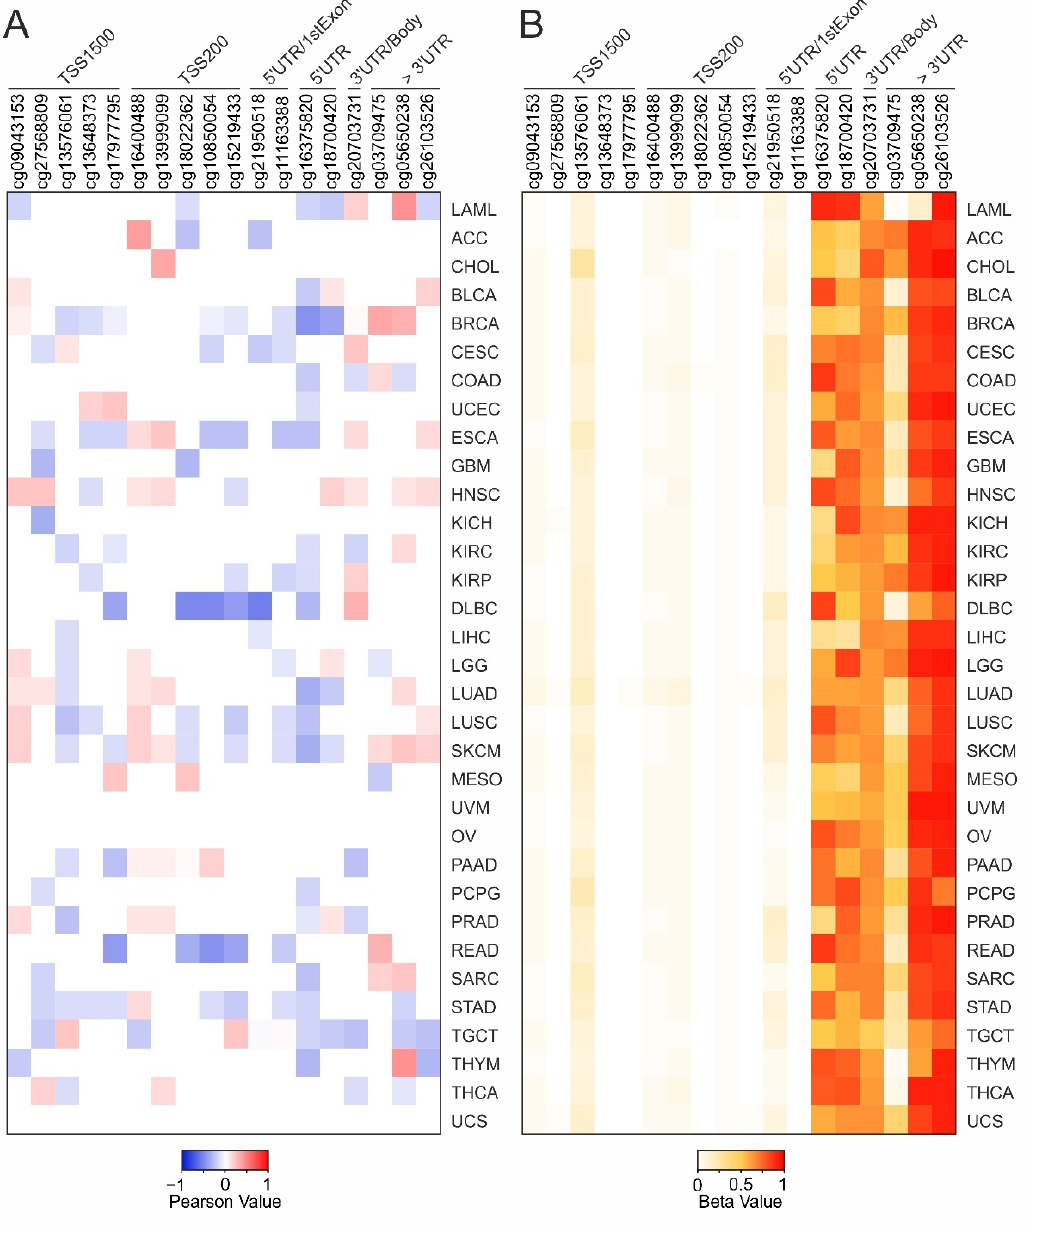
Figure 4. Correlation analysis between IL6ST expression and DNA methylation for each tumor type. ( A ) The heatmap shows the significant ( p ≤ 0.05) Pearson’s correlation coefficients ≤ −0.3 (blue) or ≥ 0.3 (red). ( B ) DNA methylation levels of IL6ST CG probesets for each tumor type. The heatmap cell represents the mean values of methylation levels for each CG probeset.